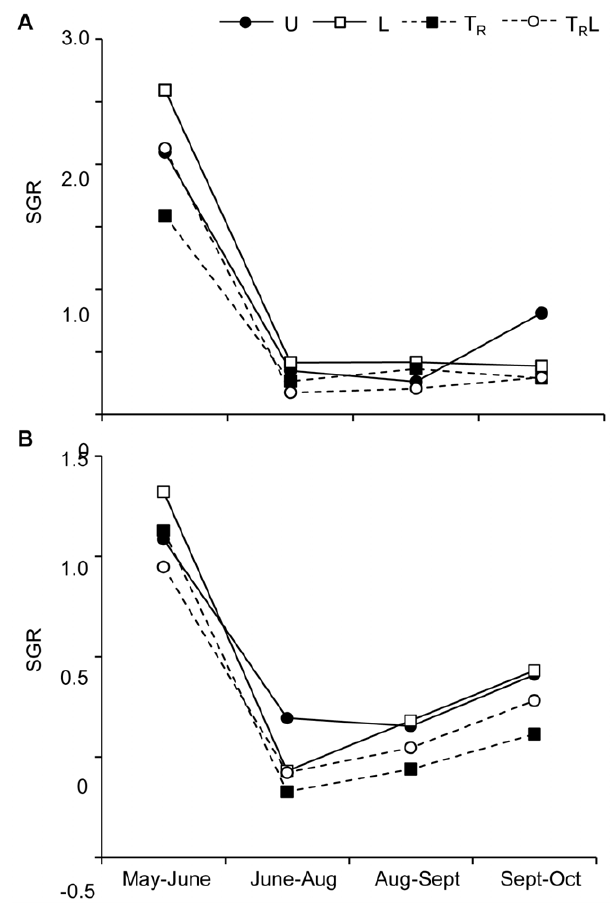
Figure 8. Trout specific growth rate. The specific growth rate (SGR; biomass data [% per day]) of young (A) and old (B) trout in unmanipulated (U), light (L), terrestrial invertebrate reduction (T R ) and terrestrial invertebrate reduction 6 light (T R L) treatments during the four study periods. Note that scale of the y-axis differs between size classes. Error bars have been omitted for clarity.